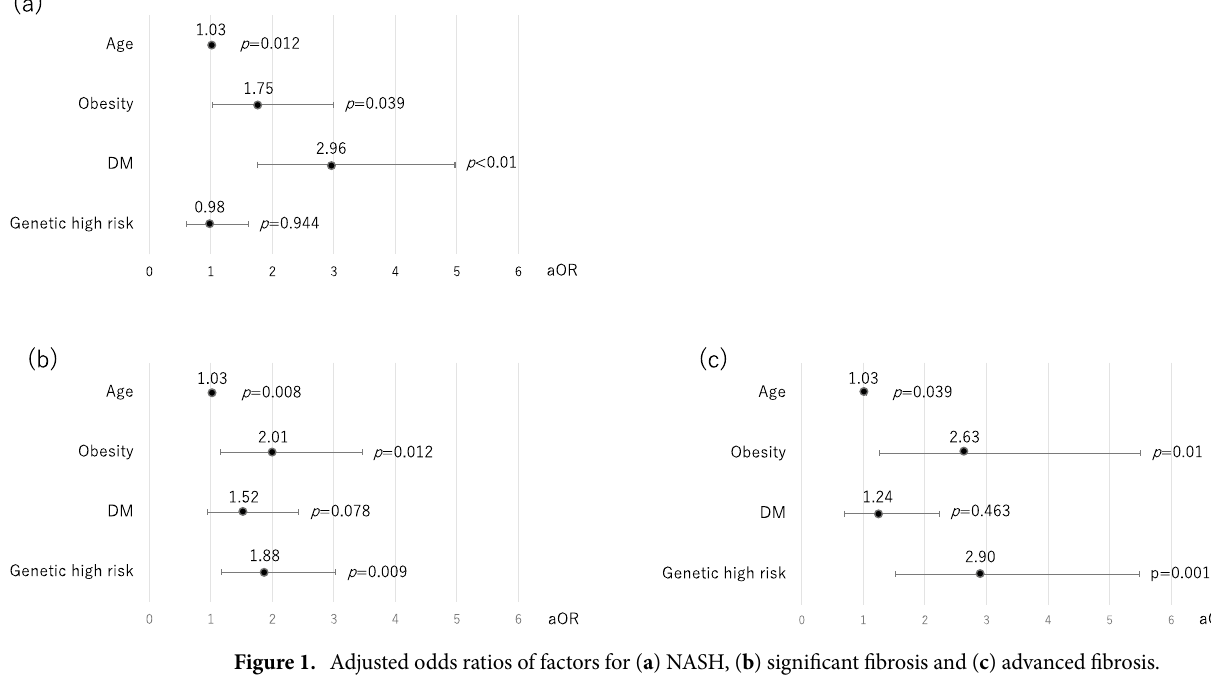
Figure 1. Adjusted odds ratios of factors for ( a ) NASH, ( b ) significant fibrosis and ( c ) advanced fibrosis.